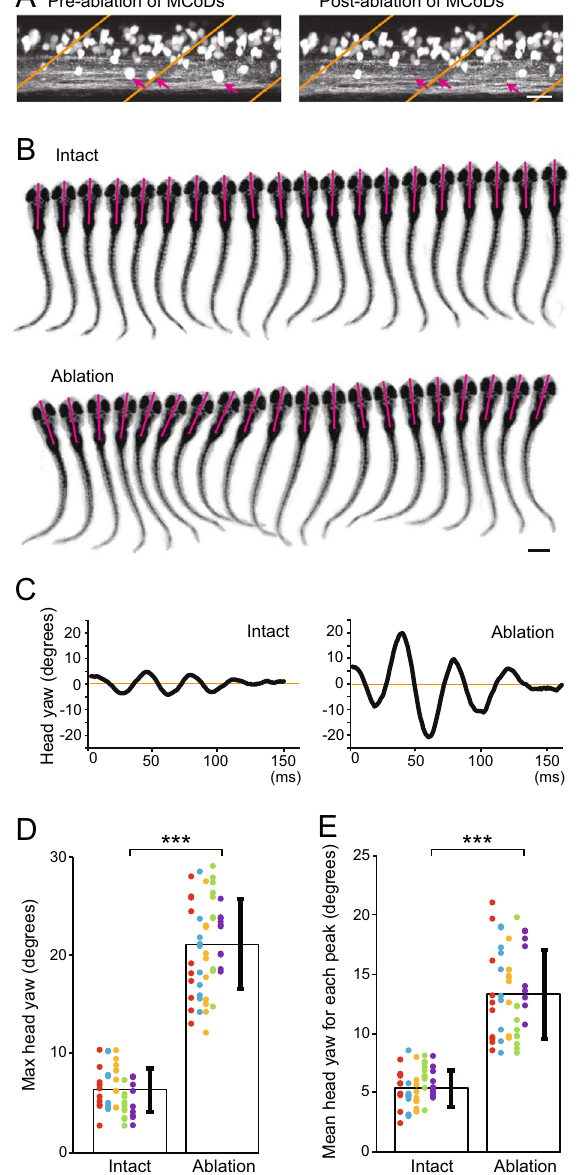
Figure 3. Ablation of MCoD neurons lead to the increase of head-yaw displacement during spontaneous swimming. ( A ) Confocal stacked images of Tg[ evx2 -hs:GFP] fish before (left) and after (right) laser ablation. Images of two hemi-segments are shown. Magenta arrows show MCoD neurons that were chosen for laser ablation. MCoD neurons can be identified by their very ventral location in the spinal cord. Brown lines show boundaries of muscle segments. Scale bar, 20 μm. ( B ) Successive images captured at 1000 frames per second of larval zebrafish swimming. Images of every three frames (3 ms interval) are shown. Magenta bars depict the head directions in each frame. Top, images of an intact fish. Bottom, images of an MCoD-ablated fish. Scale bar, 500 μm. ( C ) Graphs of head yaw angle (y axis) versus time (x-axis) during swimming. Left, intact fish. Right, MCoD-ablated fish. ( D ) Maximum head yaw angle of intact and MCoD-ablated fish during swim bouts. Five fish were examined for each fish type. For each fish, 10 swim bouts were examined. Data obtained from the same fish are color coded. ( E ) Mean head yaw angle for displacement peaks of intact and MCoD-ablated fish during swim bouts. Five fish were examined for each fish type. For each fish, 10 bouts were examined. Data obtained from the same fish are color coded (the same fish as D ). *** p < 0.001 (two-tailed t